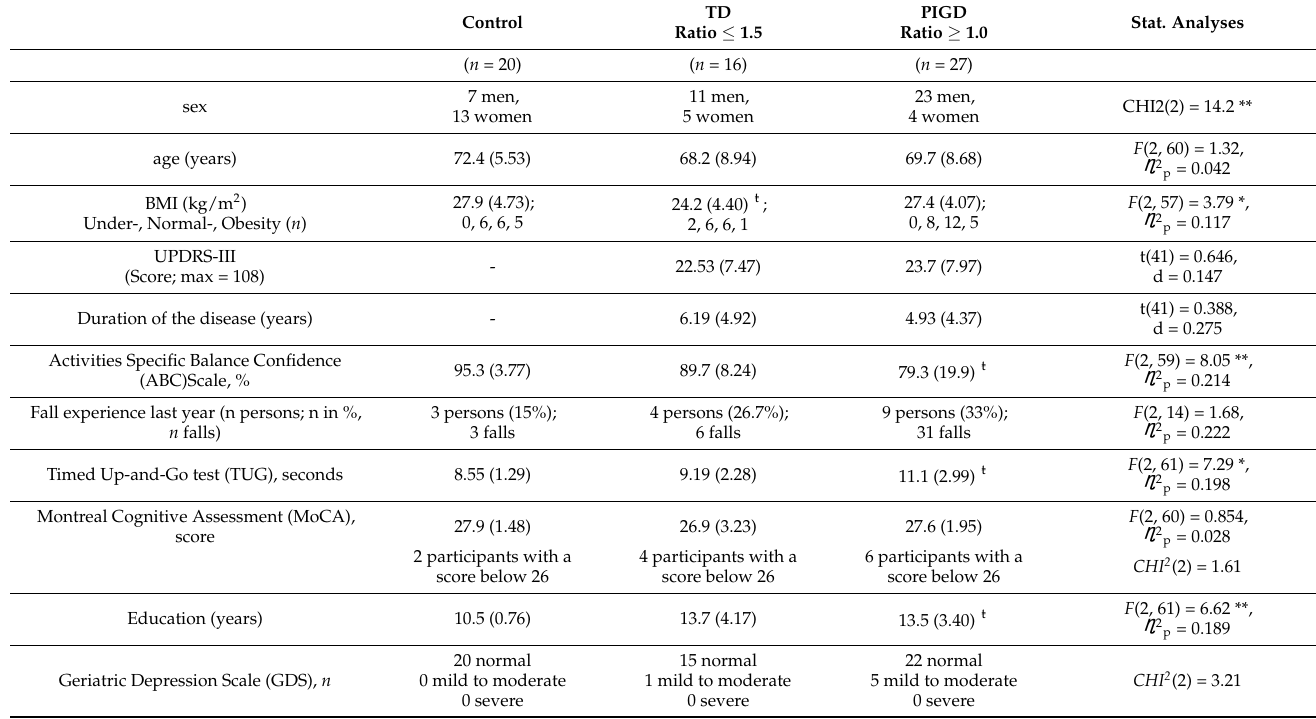
Table 3. Characteristics of PD patients differentiated into motor phenotypes TD and PIGD, including mean values (standard deviation) and test values of UPDRS-III.